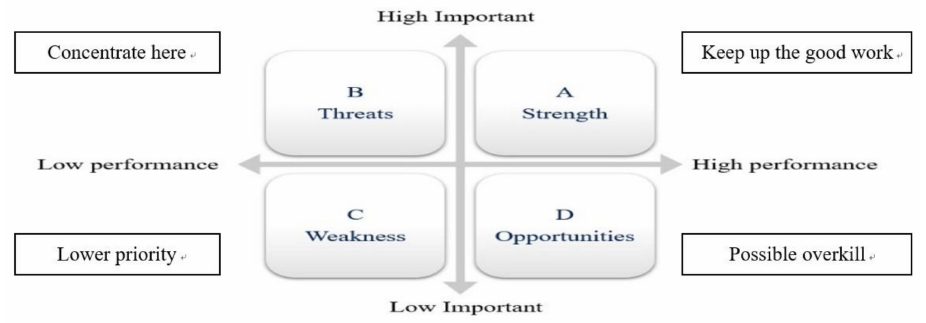
Figure 2. Evaluation framework for importance and performance analysis (Revised from